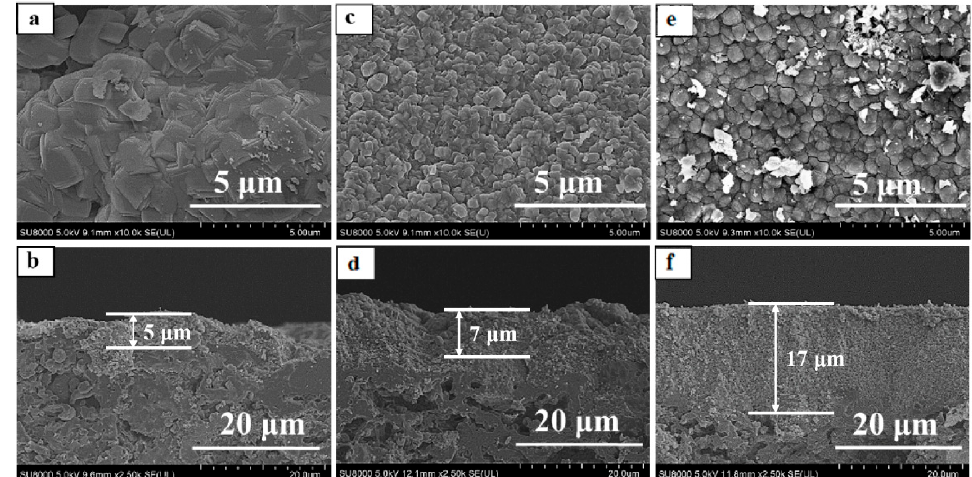
Figure 2. XRD patterns of TS-1 zeolite membranes with different Ti/Si ratio seeded crystals. ( a ) M-1; ( b ) M-2; ( c ) M-3.